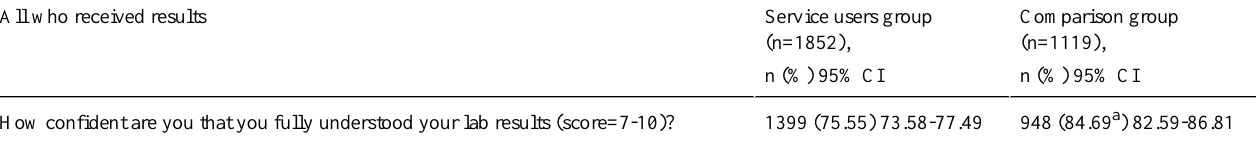
Table 3. Comprehension of lab